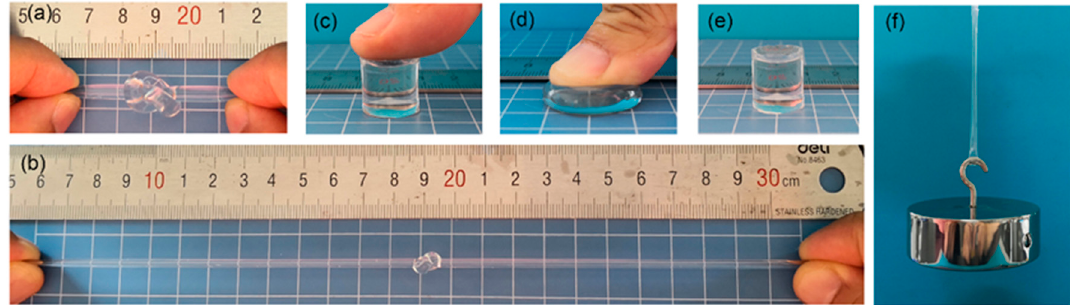
Figure 5. Illustration of the outstanding mechanical performance of NC-G gels. ( a ) Knotted, ( b ) stretch after knotting, ( c ) before compression, ( d ) under compression, ( e ) after compression, and ( f ) lift up a 1.0 kg weight.